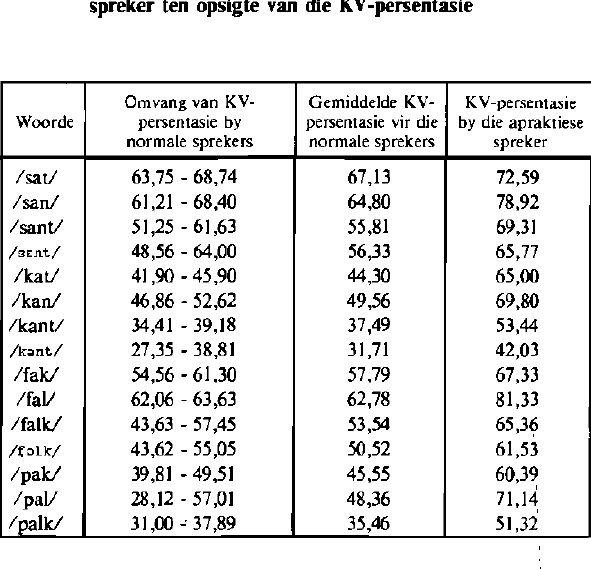
Tabel 6: Vergelyking tussen normale sprekers en 'n apraktiese spreker ten opsigte van die KV-persentasie